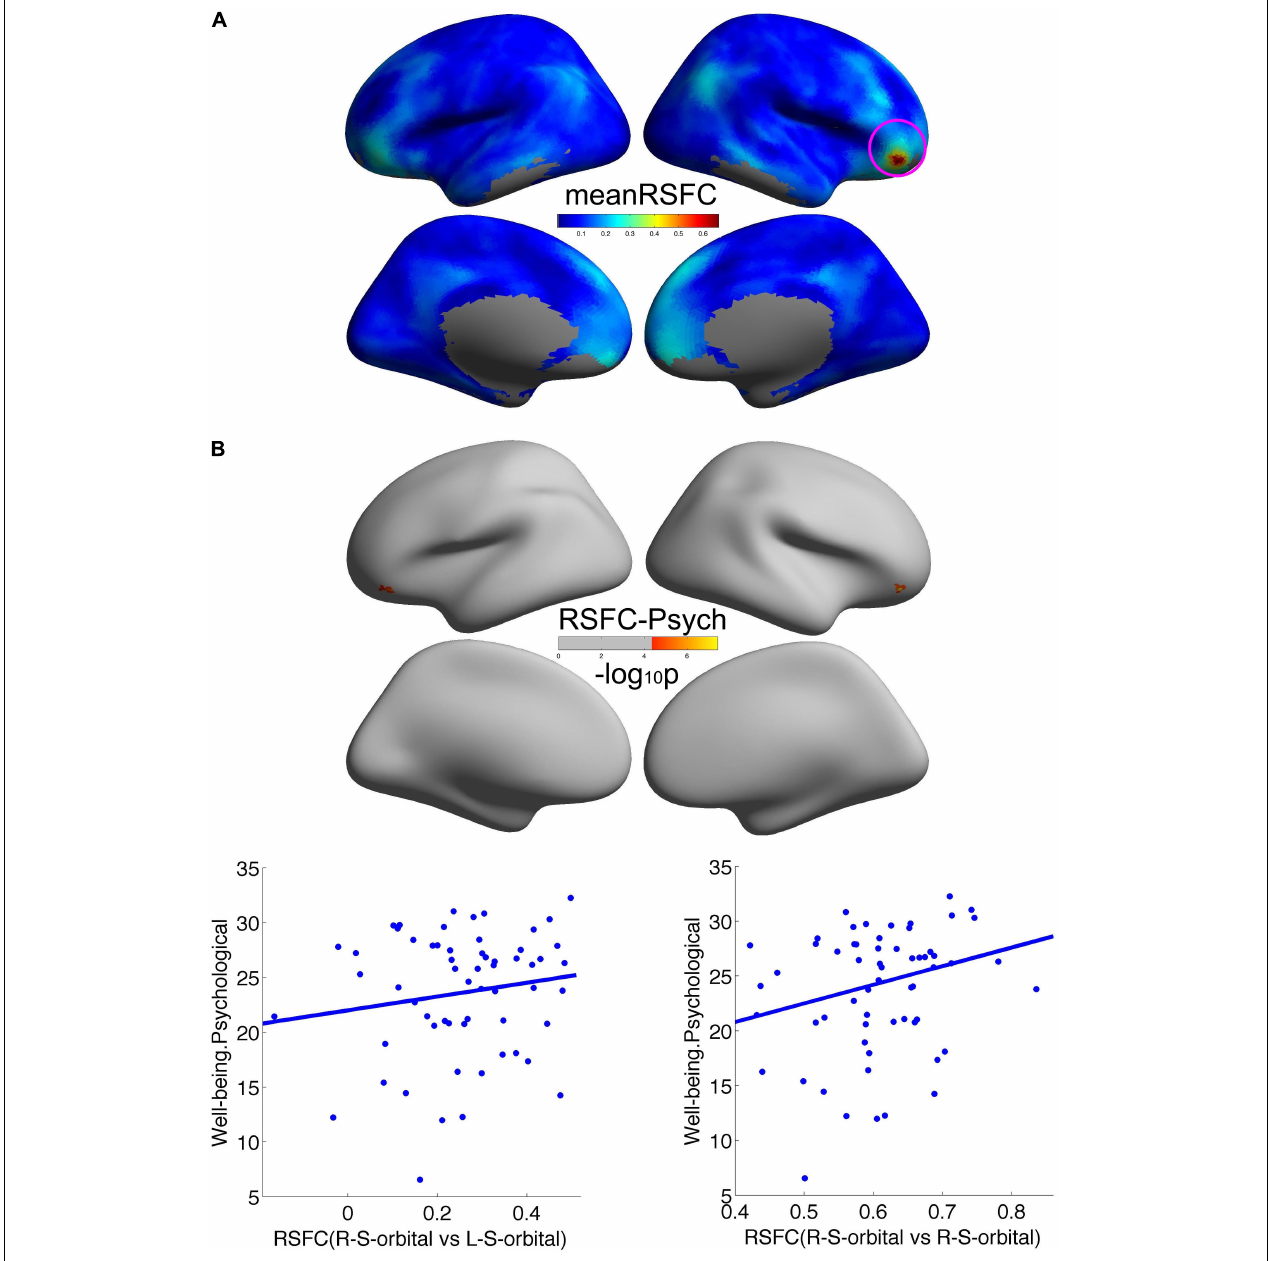
FIGURE 3 | Remote cortical connectivity and its associations with wellbeing. (A) Illustrated the average RSFC across all the participants taking the social wellbeing-related right orbitofrontal sulcus as the seed region. The remote cortical connectivity within the right orbitofrontal sulcus and the remote connectivity of contralateral orbitofrontal sulcus were both positively correlated with psychological wellbeing (B)